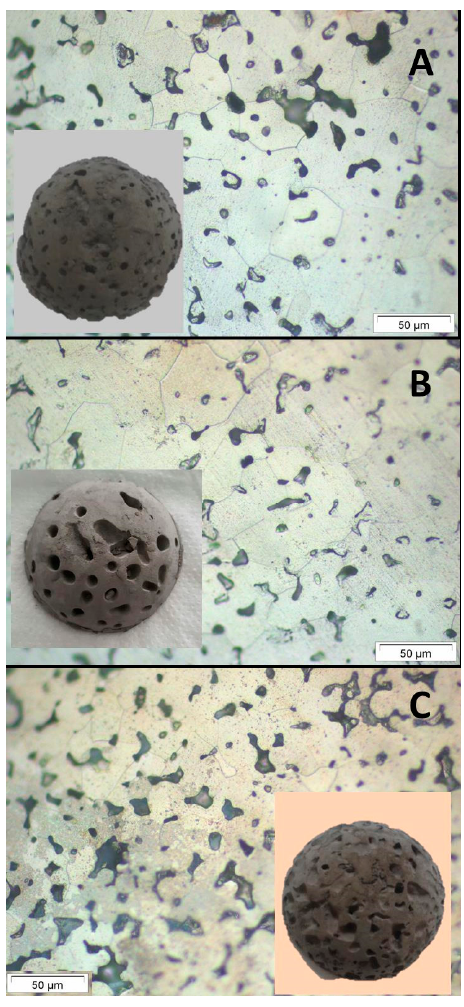
Figure 7. Pictures and micrographs of the porous titanium sintered bodies representing the different processing categories ( A ), ( B ) and ( C ).